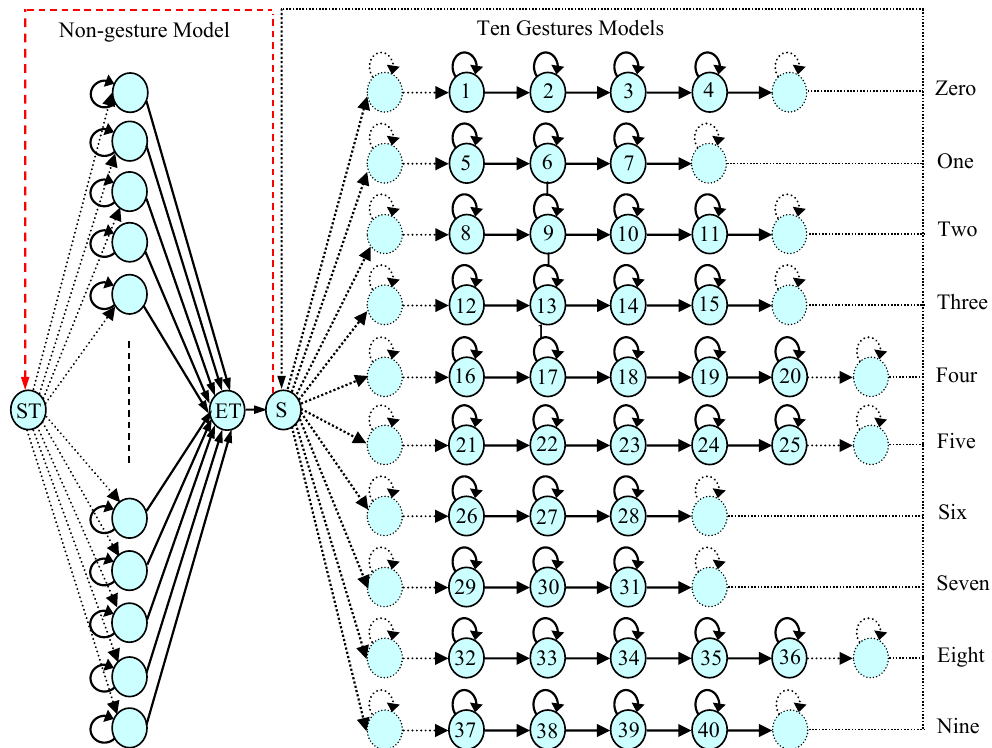
Figure 9. Network for spotting ten gestures using LRB topology shown with non-gesture